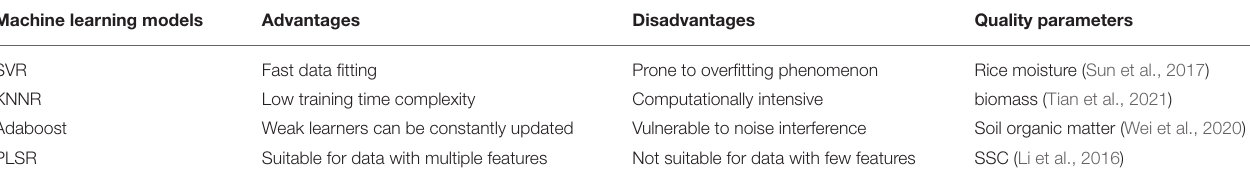
TABLE 1 | Advantages, disadvantages, and applications of machine learning models in